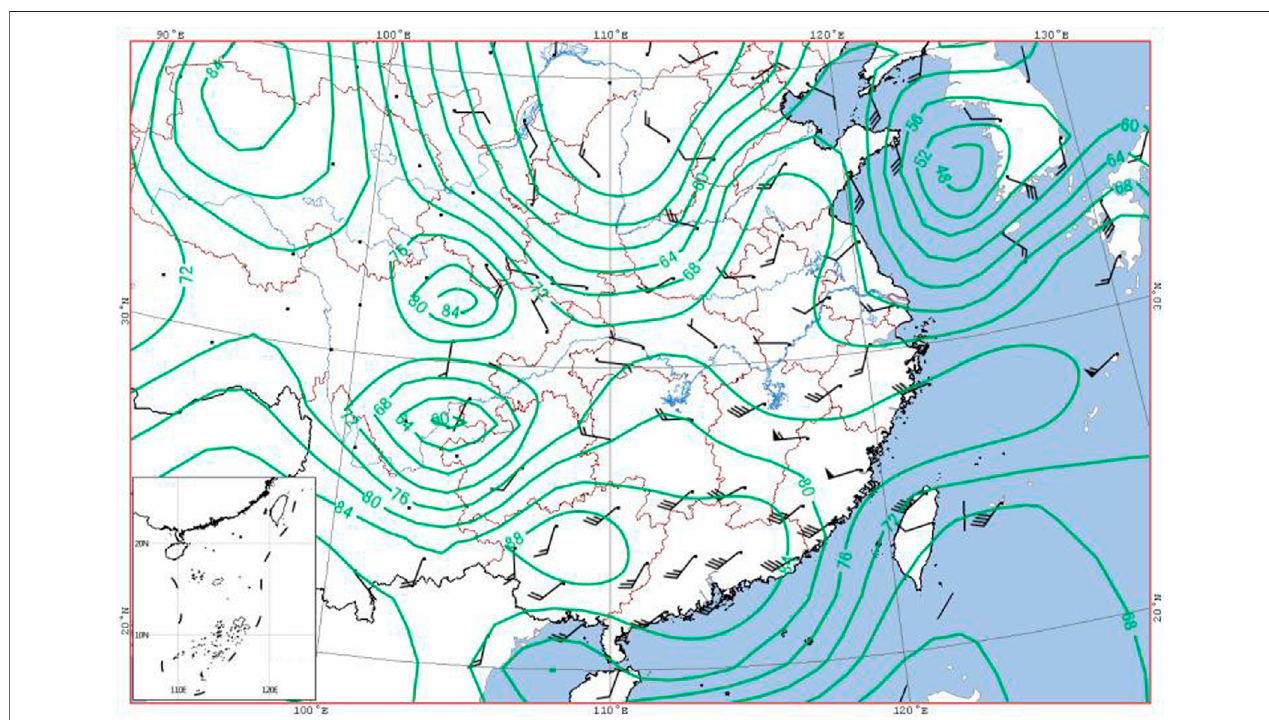
FIGURE 2 | Wind fi eld and pseudo equivalent temperature fi eld of 850 hPa at 20:00 on June 17, 2010 (green isolines).